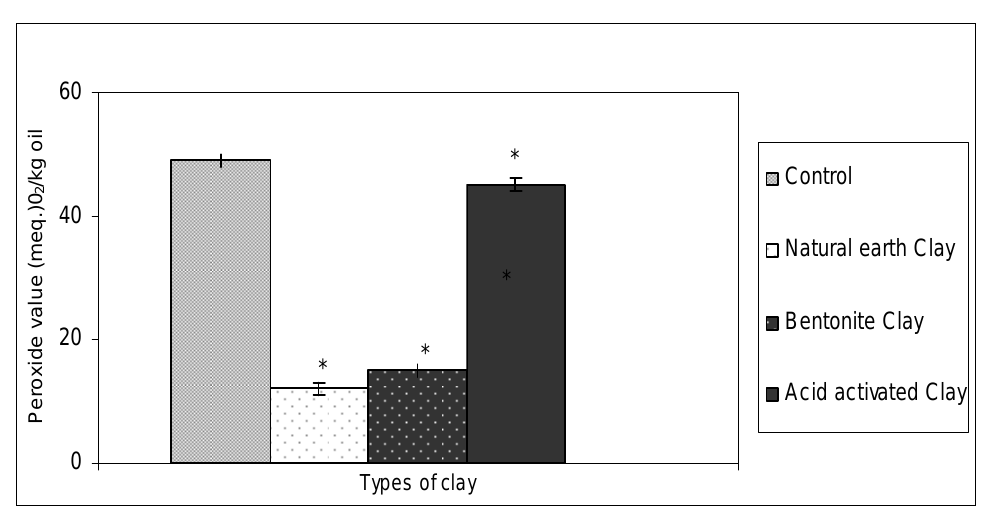
Figure 1. Ability of different types of clay in bleaching crude ostrich oil in removing peroxides.